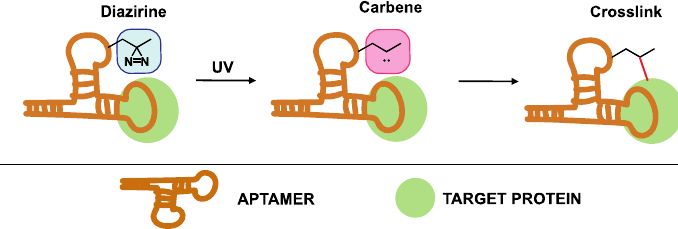
Figure 15. Principle of UV activated crosslinking between diazirine-modified aptamers and target proteins.